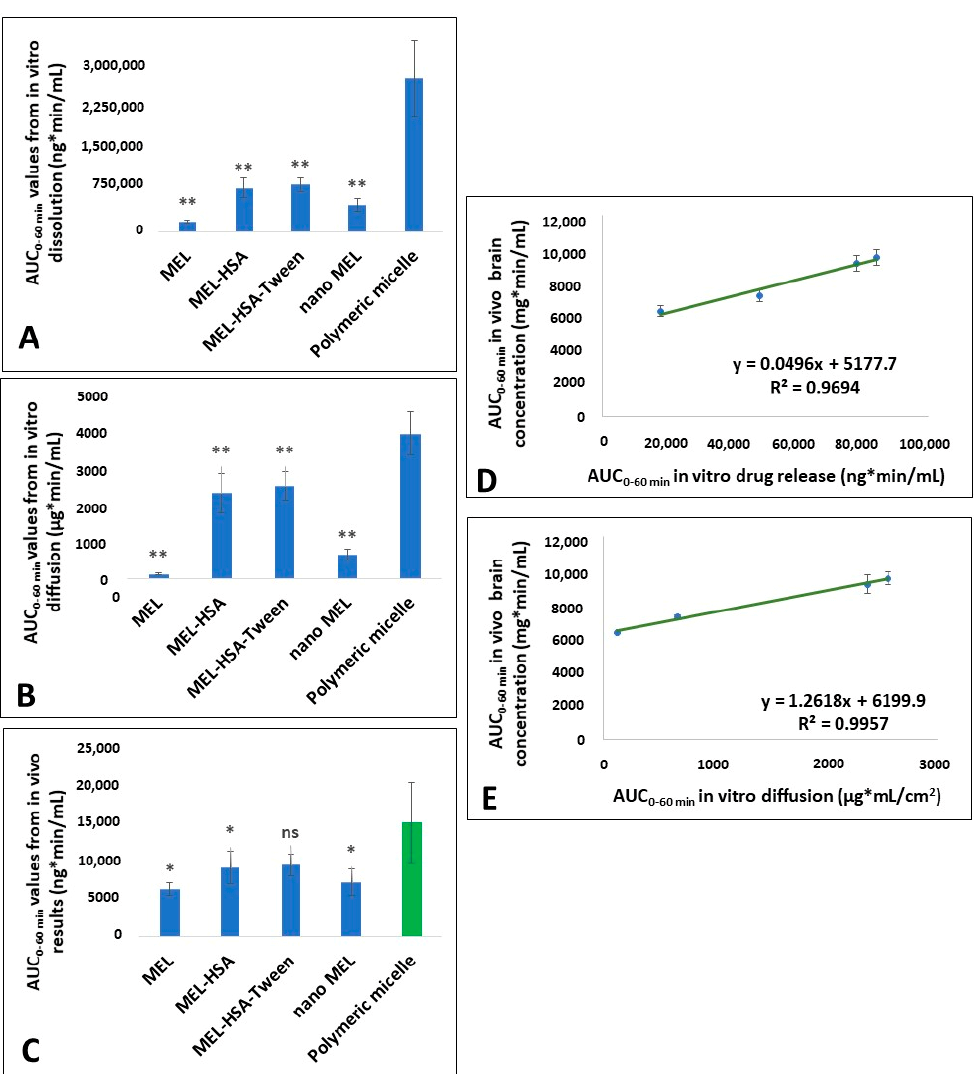
Figure 12. Figures of the IVIVC evaluation. ( A ) Calculated AUC 0–60 min values from the in vitro dissolution test; ( B ) Calculated AUC 0–60 min values from the in vitro diffusion test; ( C ) AUC 0–60 min values from the in vivo results with the predicted polymeric micelle value (marked as green); ( D ) Pearson correlation based on dissolution; ( E ) Pearson correlation based on diffusion. Statistics: * = p < 0.05; ** = p < 0.01; ns = not significant.